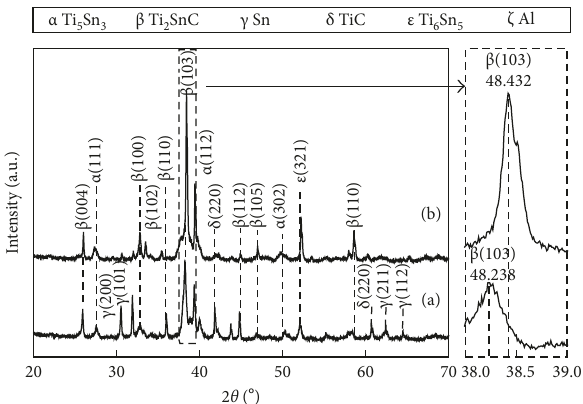
Figure 3: Sintering powders Ti 2 SnC at different molar ratios Ti :Sn : Al: C (cid:31) (a) 2 :1: 0.05:1; (b) 2:1:0.2 :1 at 1400